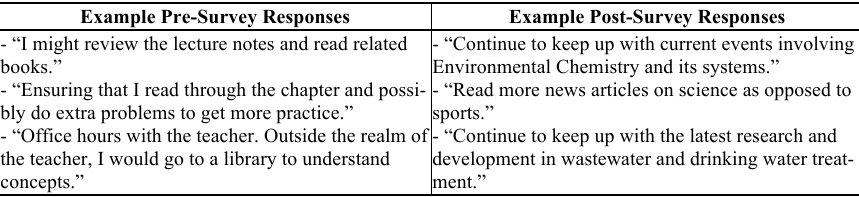
Table 3. Example Pre- and Post-Survey Responses